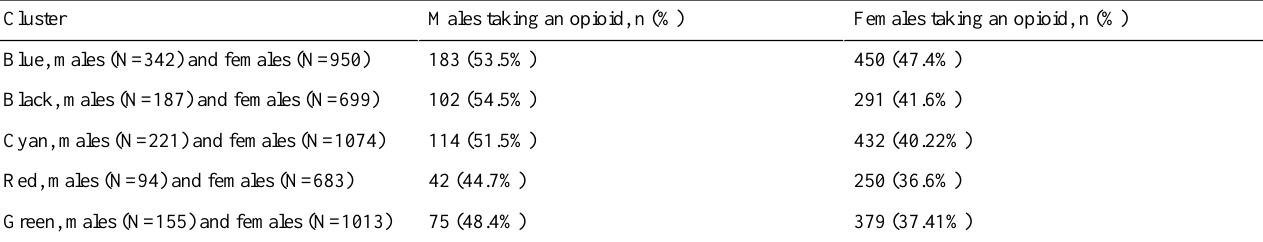
Table 5. Number and percentage of each gender reporting current opioid use within each cluster where the percentages for each gender were calculated using a denominator that comprised the number of that gender taking at least 1 current medication in a